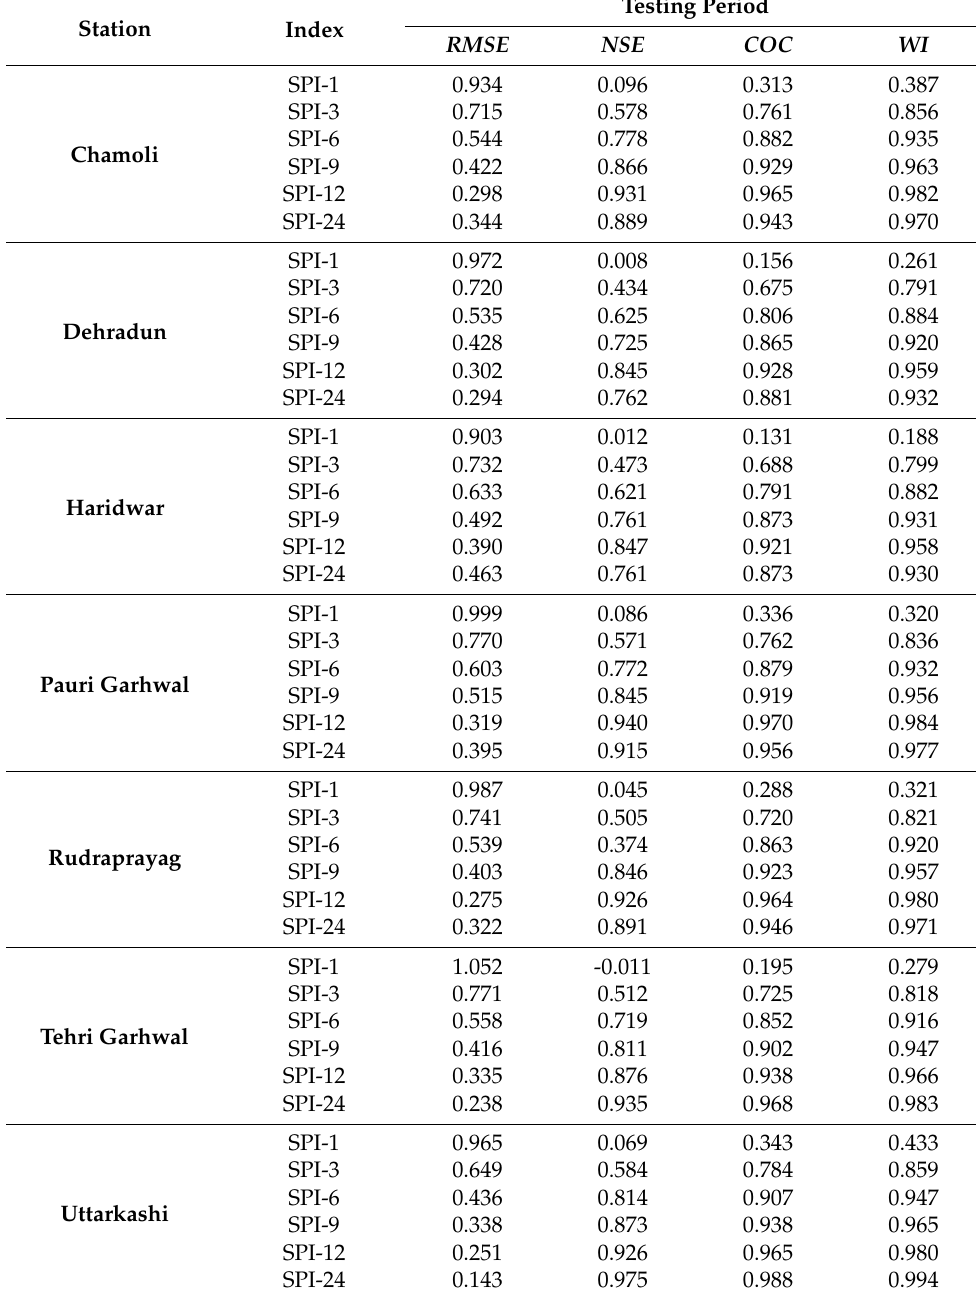
Table 6. Performance of multiple linear regression (MLR) model at study